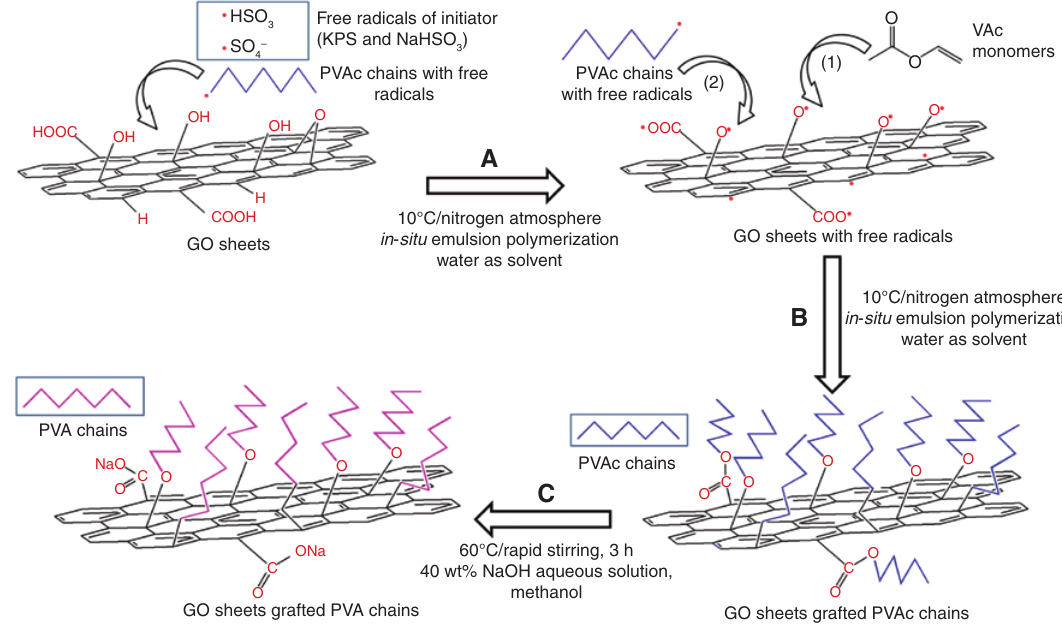
Figure 7: Process of chemical grafting modification of GO during in-situ emulsion polymerization and alcoholysis [63].